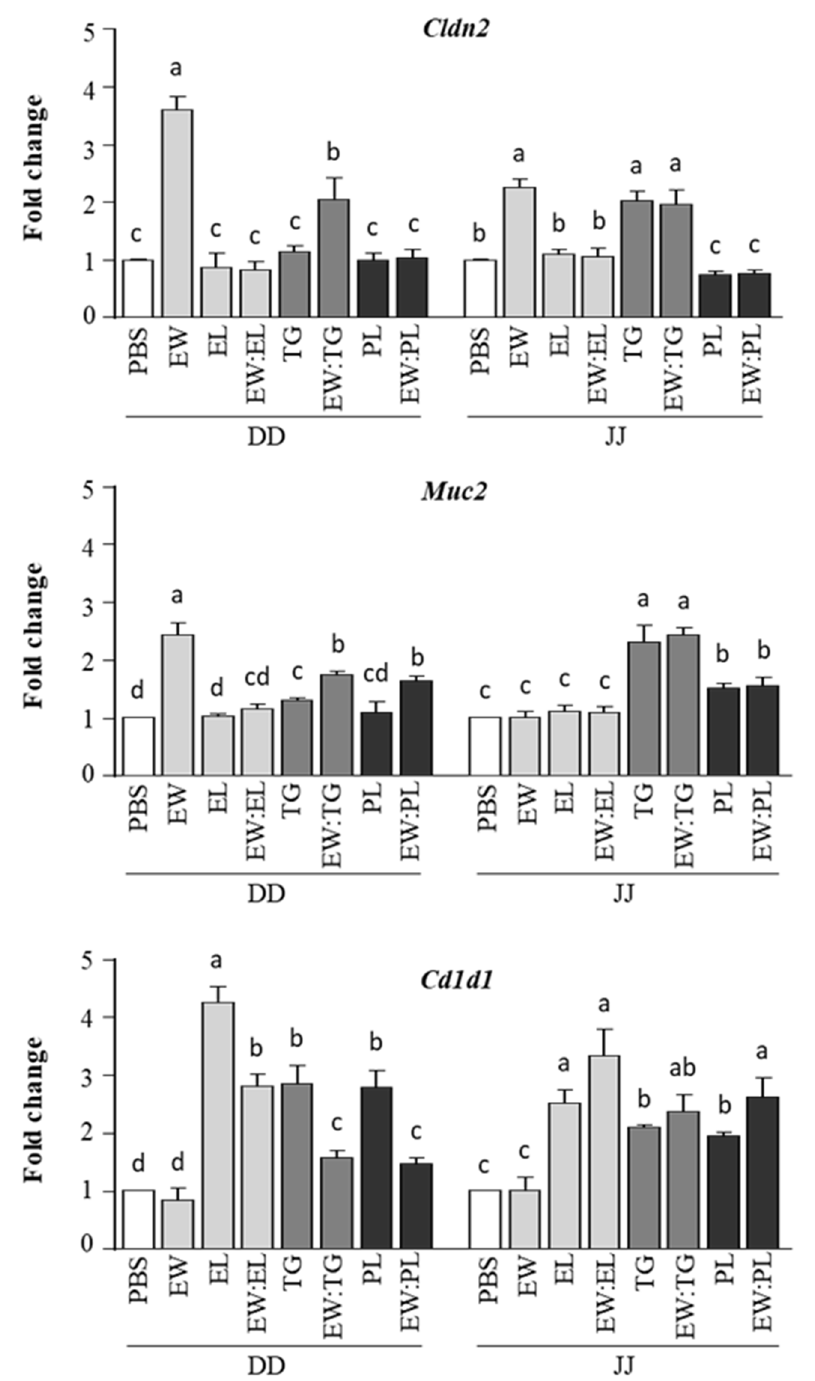
Figure 2. Relative gene expression of Cln2, Muc2 , and Cd1d1 , determined in the duodenum (DD) and jejunum (JJ) of mice intragastrically administered PBS, egg white (EW, 50 mg), egg lipids (EL, 60 mg), a triacylglyceride-enriched fraction (60 mg, TG), a phospholipid-enriched fraction (60 mg, PL), and their mixtures (50 mg:60 mg) with EW (respectively EW:EL, EW:TG, EW:PL) for 6 consecutive days. Gene expression was normalized to the reference gene Actb and compared with mice administered PBS. Data are expressed as means ± SEM ( n = 6). Different letters indicate statistically significant differences ( p < 0.05) among different mouse groups.